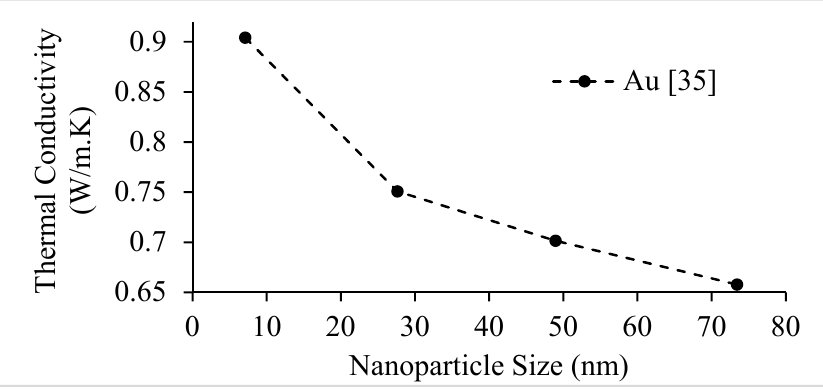
Figure 9. Variation of Au–water nanofluid thermal conductivity at room temperature as a function of nanoparticle size, for a nanoparticle volume concentration of 𝜑 = 0.00026% .